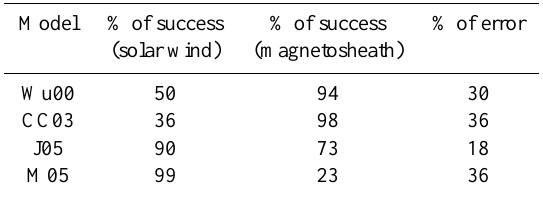
Table 2. Success and error rates of the models’ predictions during the five MC